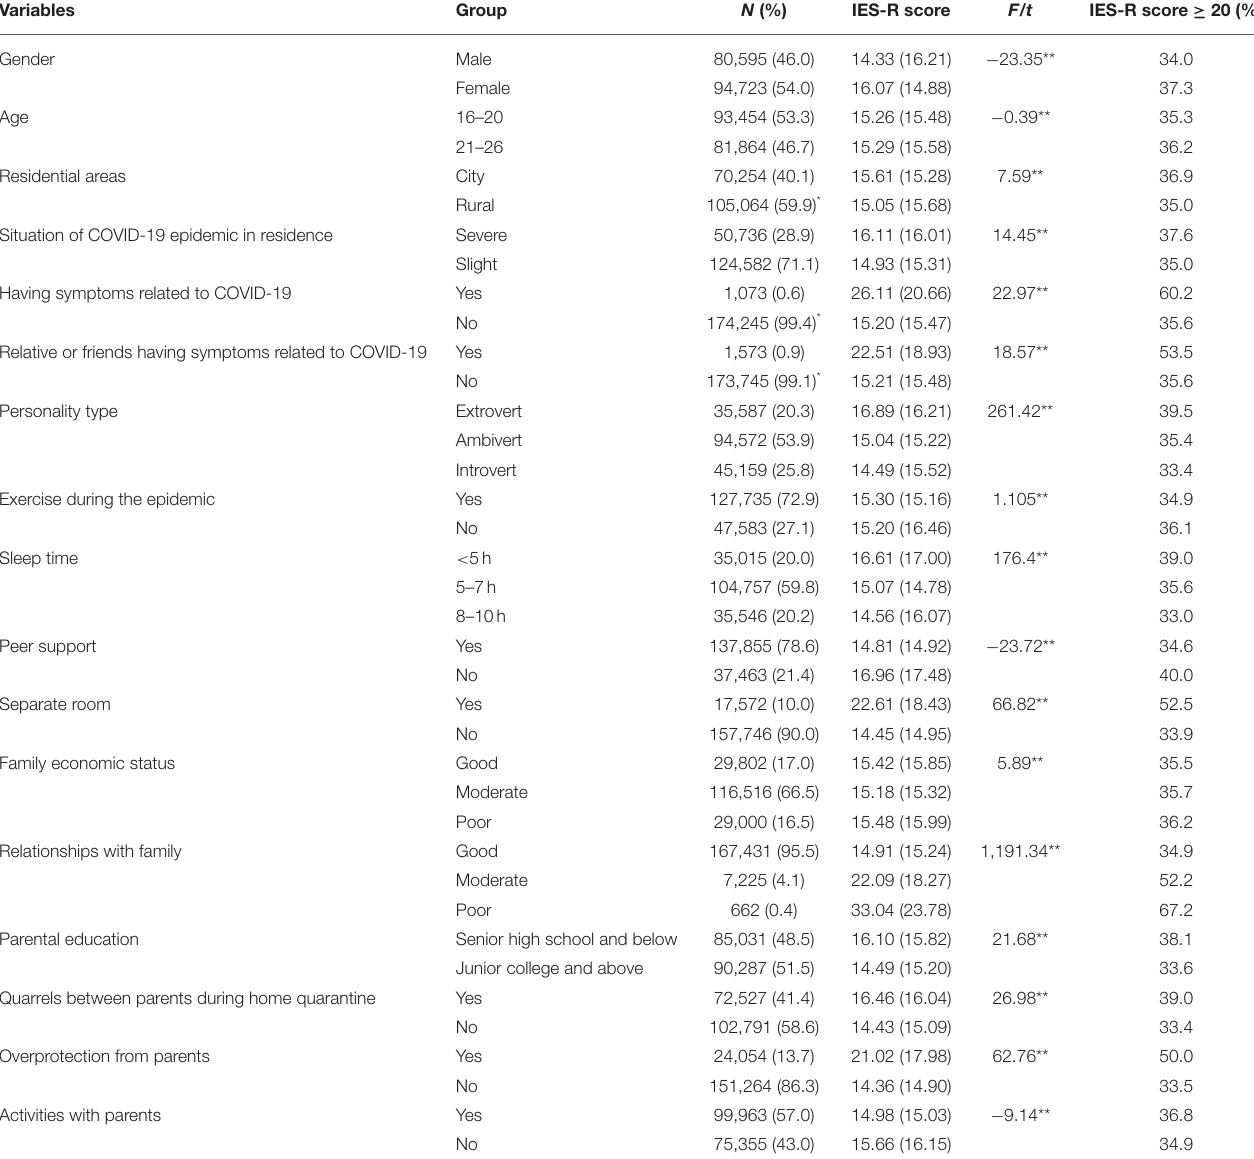
TABLE 2 | Socio-demographic factors for the sample of Chinese adolescents.